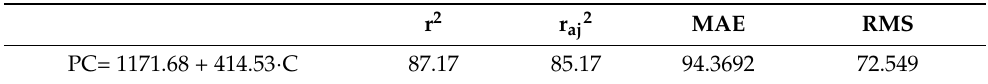
Table 9. Ratio of calorific value to carbon